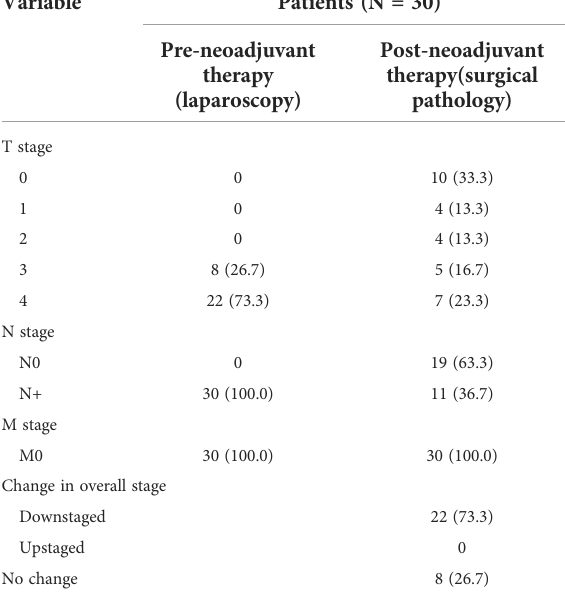
TABLE 3 The downgrade changes of TNM staging in 30 patients before and after neoadjuvant chemotherapy. No. (%).